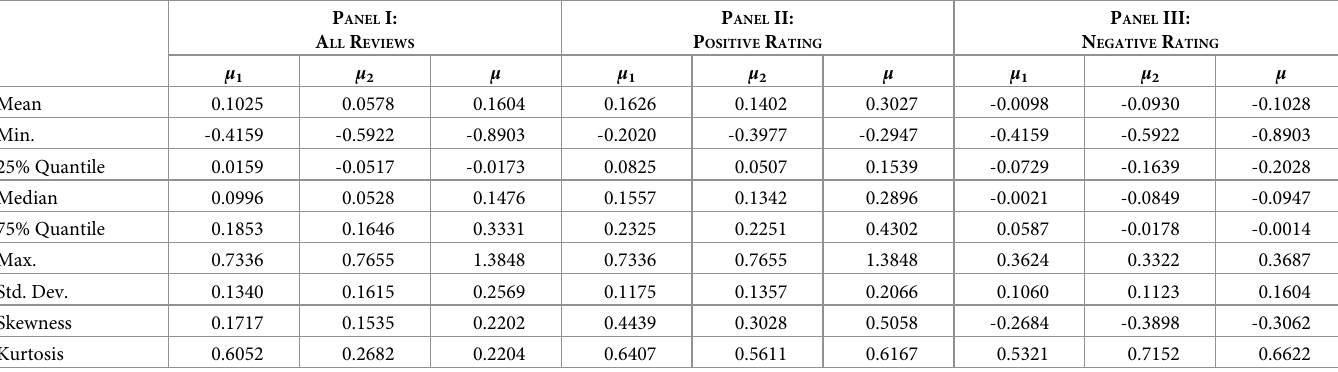
Table 6. Summary statistics for hypothesis testing with movie